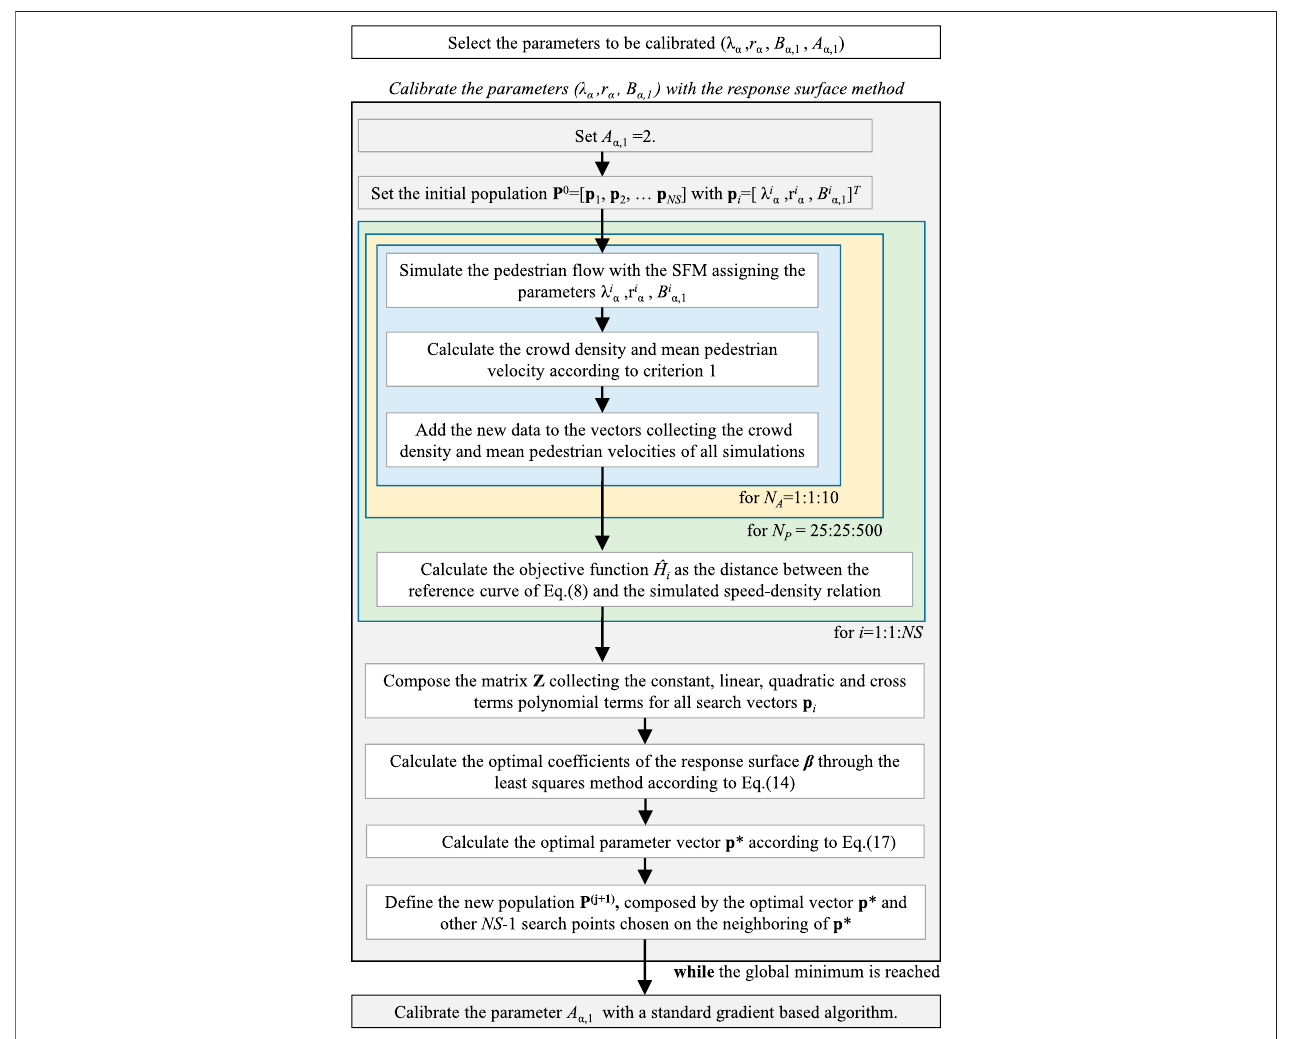
FIGURE 5 | Flowchart of the updating process. N A is the number of analyses performed for each case.